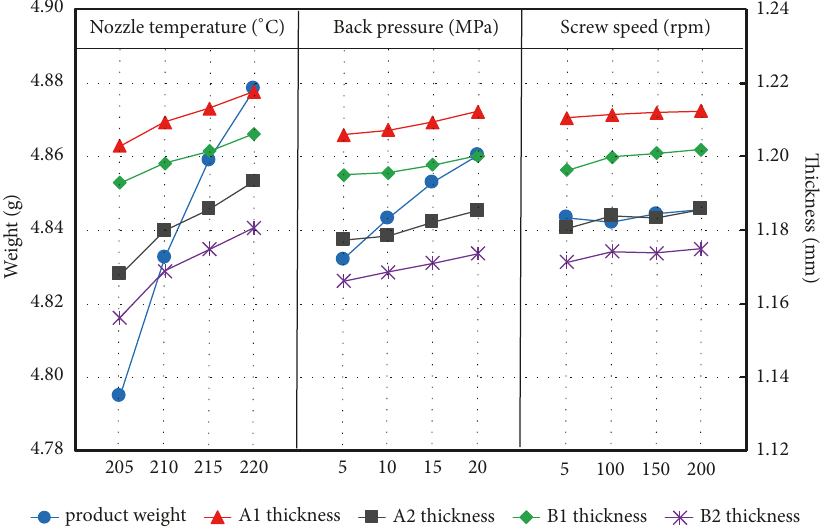
Figure 8: Variation of part weight and thickness for various plasticizing